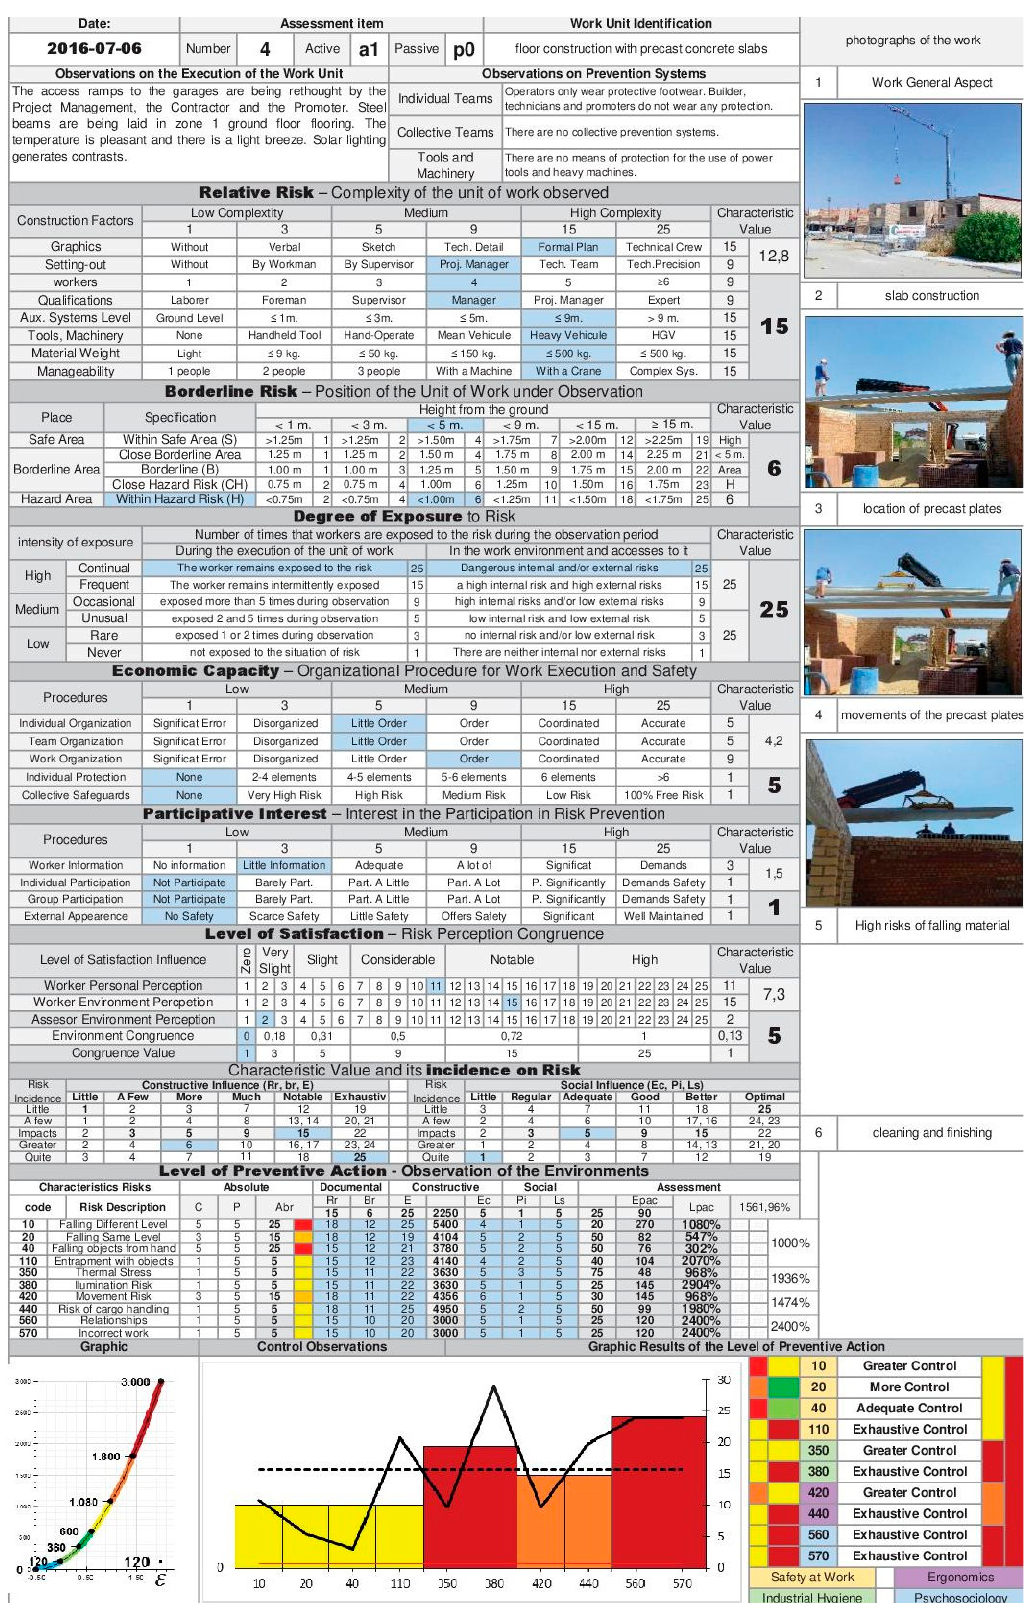
Figure A1. A specialized technical observation data collection.